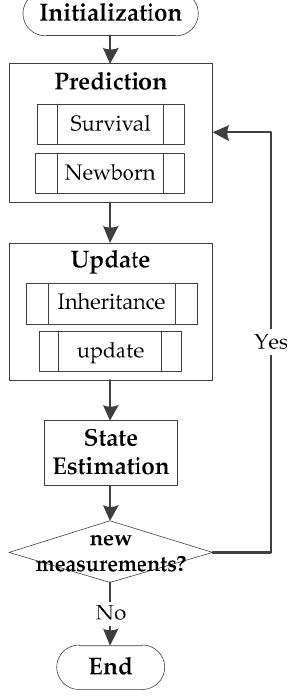
Figure 4 . Block diagram of the CBMeMber filter.